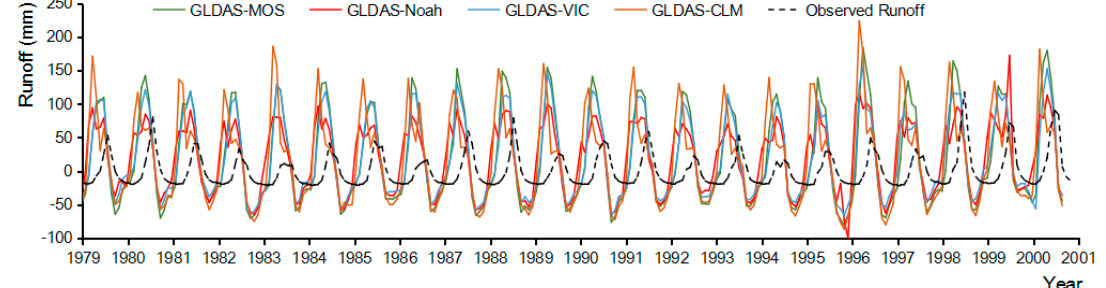
Figure 10. Time series of monthly runoff calculated from GLDAS and observed runoff data. Table 1. Annual amplitude, cycle, phase, and linear trend of runoff based on the least square method. Dataset